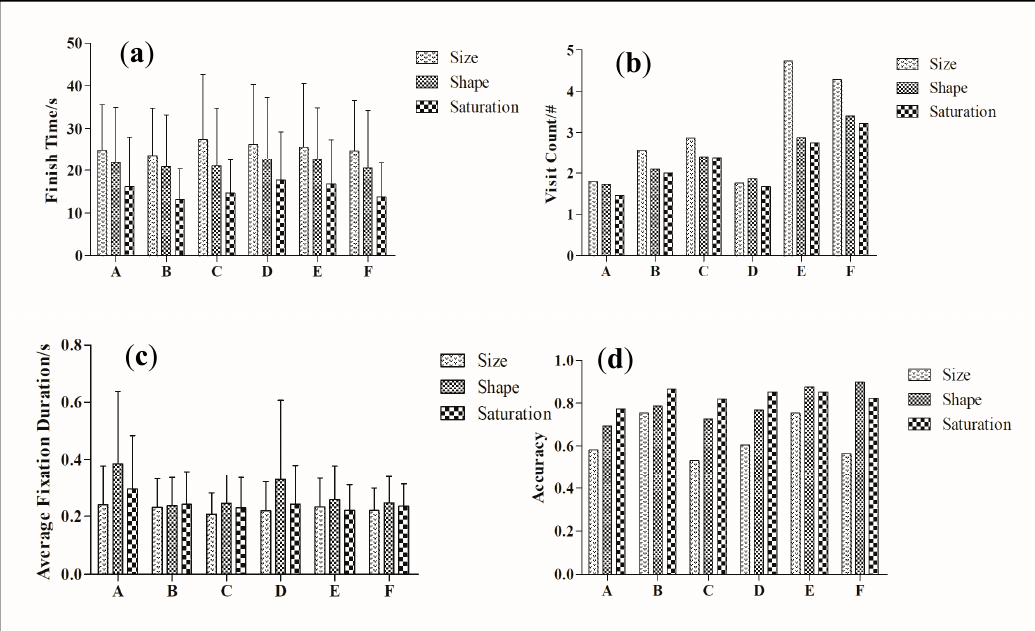
Figure 6. Statistics of the indices calculated for Exp. 2 (constancy): ( a ) FT ; ( b ) AFD ; ( c ) VC and ( d ) AC .